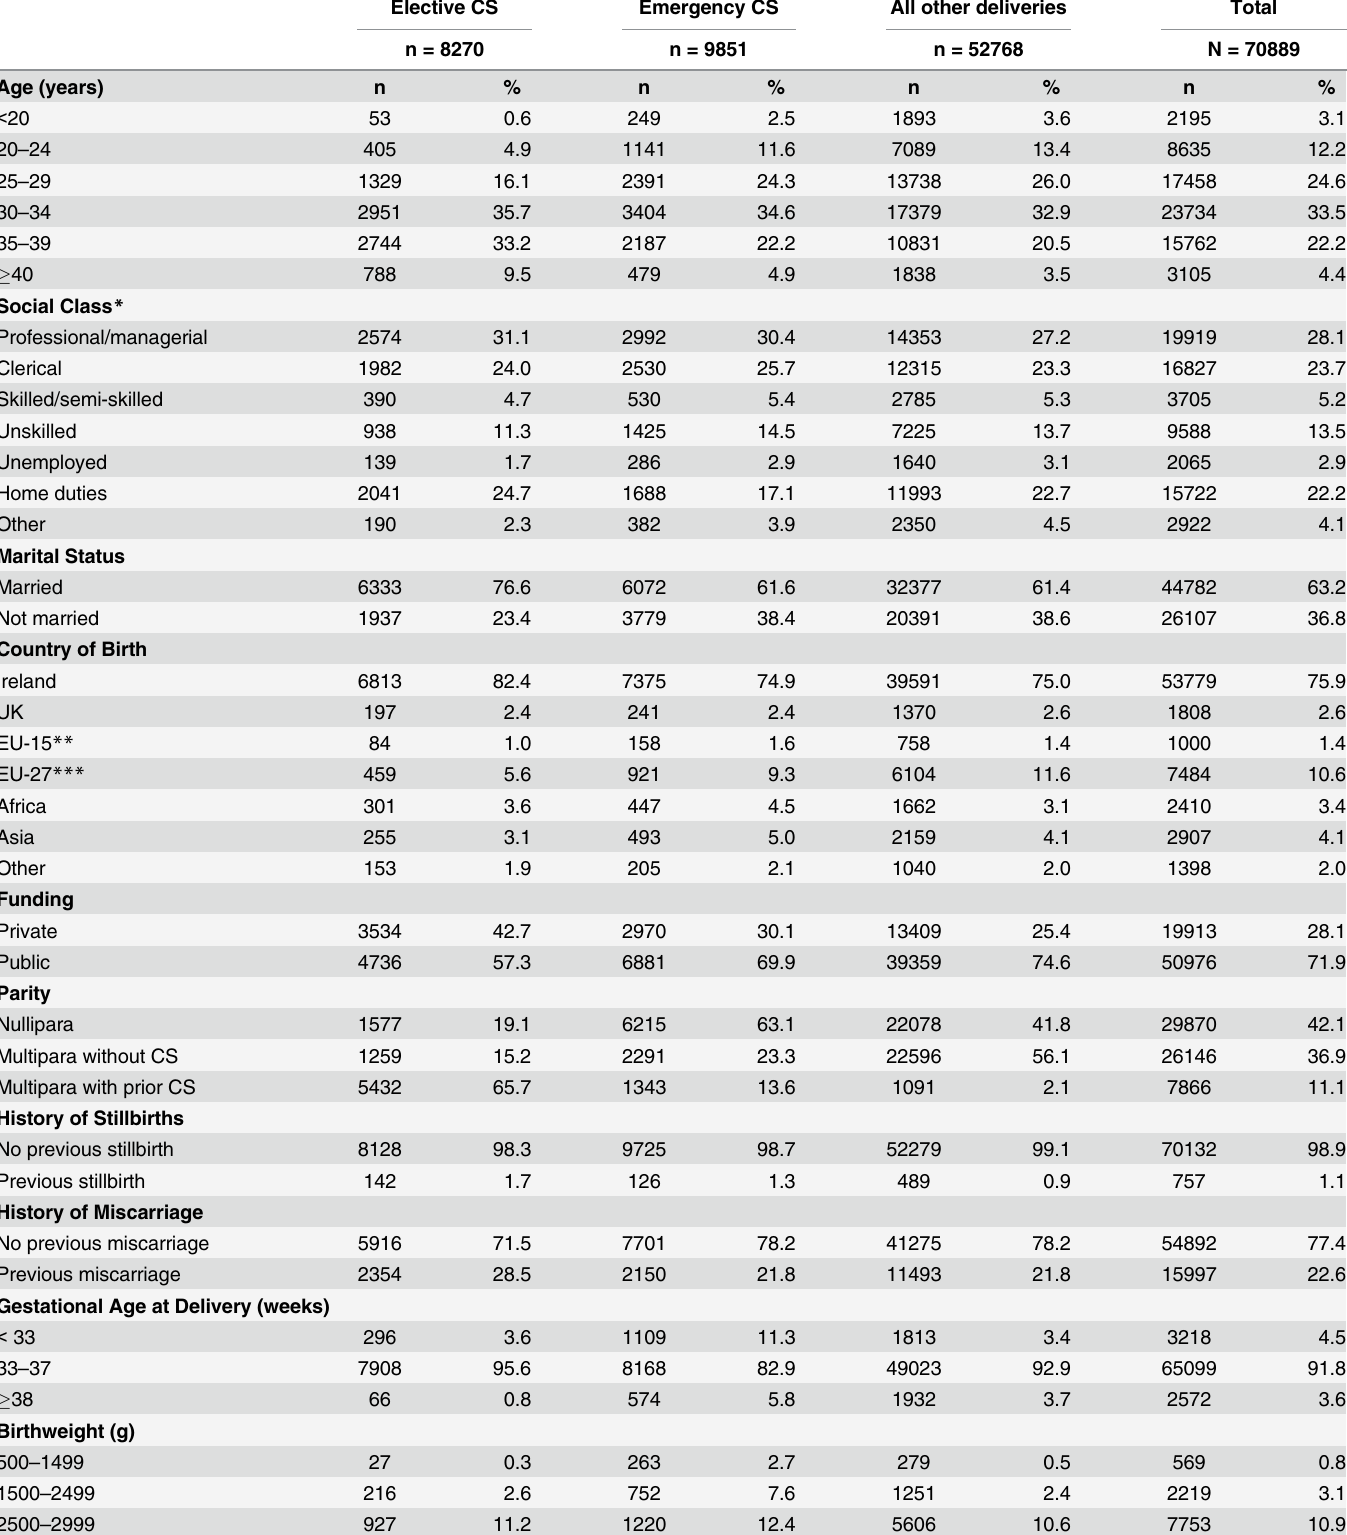
Table 1. Descriptive characteristics of study